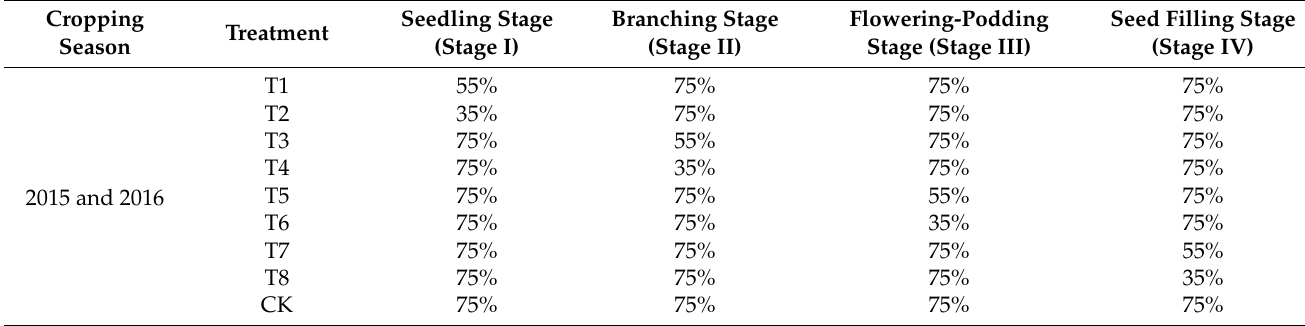
Table 3. Percentage of lower limits of soil water content relative to field capacity at each soybean growth stage for different experimental treatments in 2015 and 2016